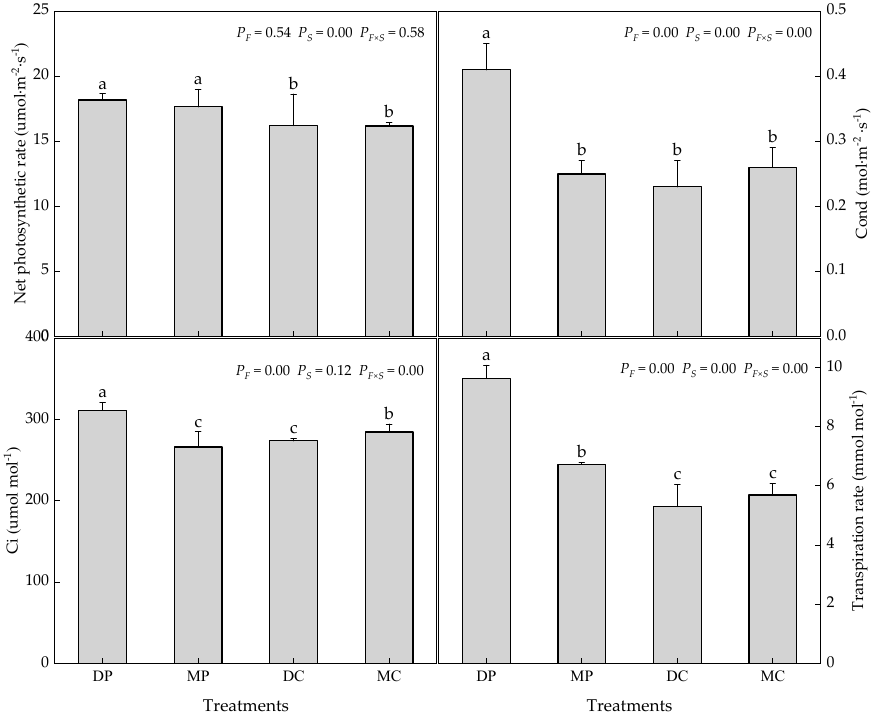
Figure 1. The photosynthetic parameters of tomato leaves at 30 days of fruit age. Different super- scripts in each treatment indicated significant differences at p < 0.05. Table 5. Effect of digested pig slurry on carbohydrate contents in leaves at 30-d fruit age. Treatment